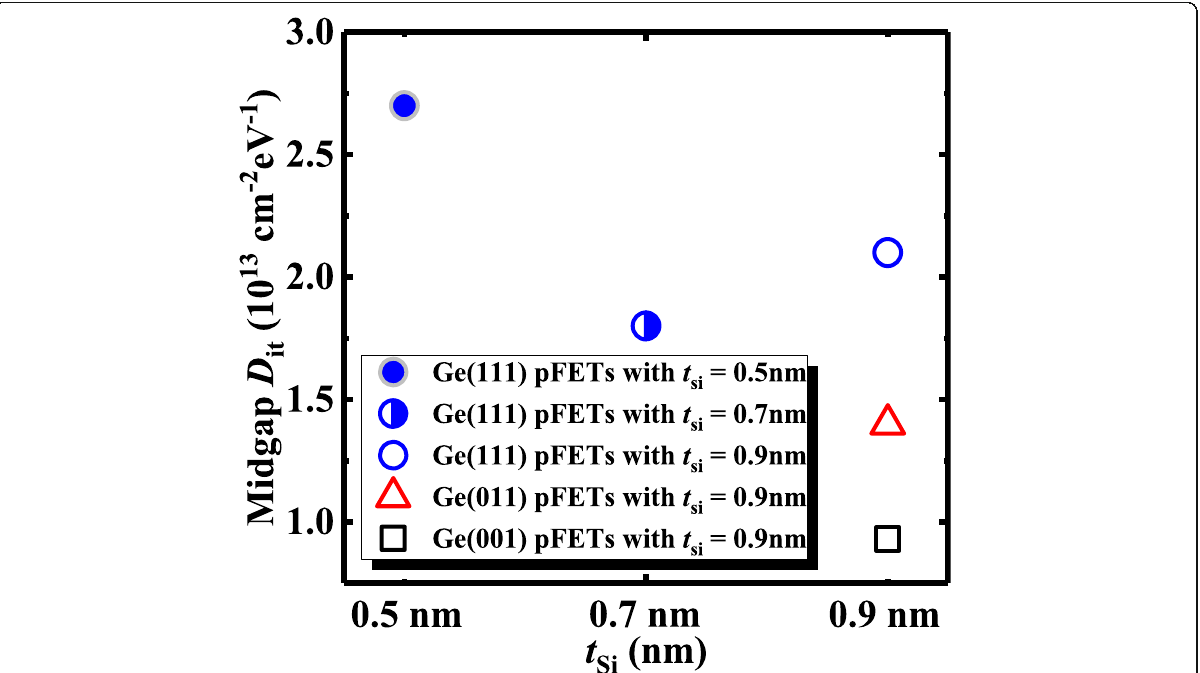
Fig. 12 D it versus the thickness of amorphous Si with various Ge surface